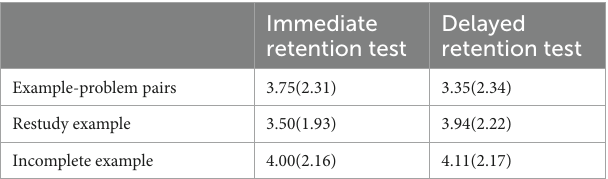
TABLE 1 The effect of retrieve practice on problem-solving under different initial test conditions.